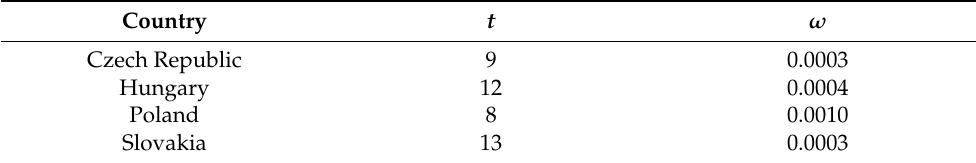
Table 4. The delay of Poland, the Czech Republic, Hungary and Slovakia in relations to Germany (I variant). Country t ω 9 0.0003 0.0004 0.0010